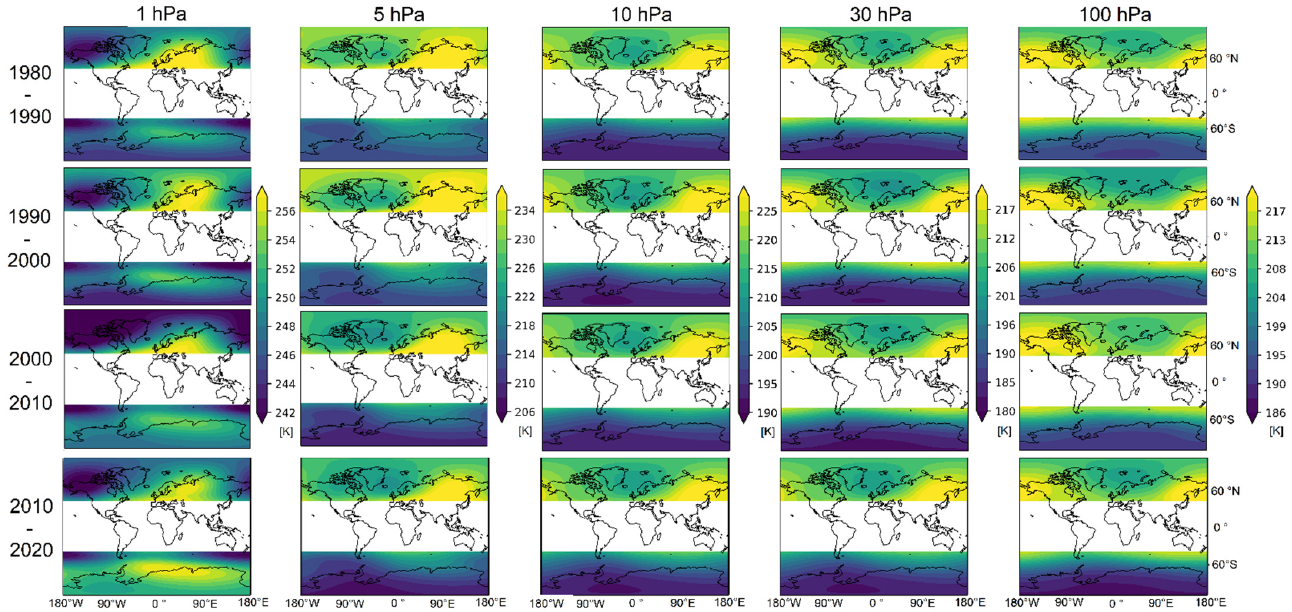
Figure 1. Temperature climatology ( upper panels ) and trends ( lower panels ) for January during 1980–2020 at 1, 10, 50 and 100 hPa using ERA5 and MERRA-2.